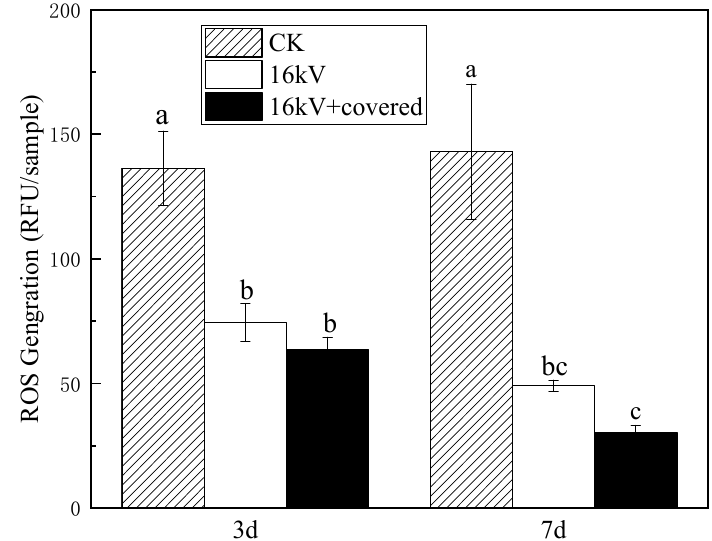
Figure 10. Reactive oxygen species (ROS) content changes of seedlings after HVEF treatment (Different letters indicate statistically significant differences between treatments ( p < 0.05)).